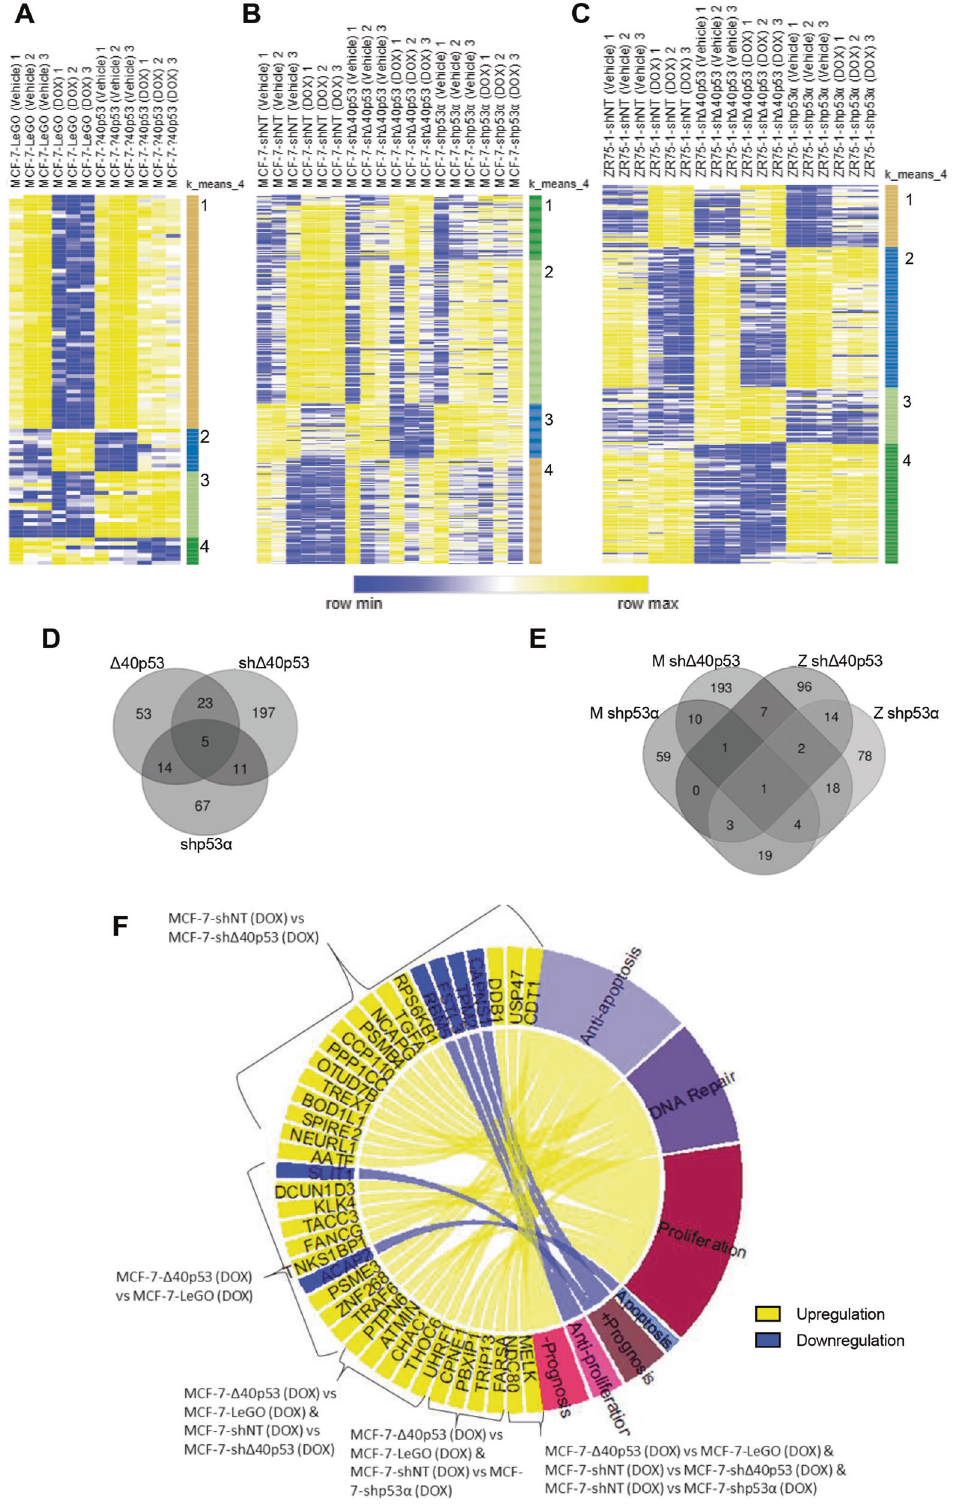
Overall, our results indicate that Δ 40p53 is upregulated following DOX, forms complexes with p53 α , stabilises p53, and impairs p53 ’ s activation and transactivation of target genes. A high Δ 40p53:p53 α ratio alters the DDR in breast cancer cells, and to some extent, Δ 40p53 behaves similar to TAD1-truncated p53, where p53 loss-of- function is evident in the lack of cell cycle, DNA repair